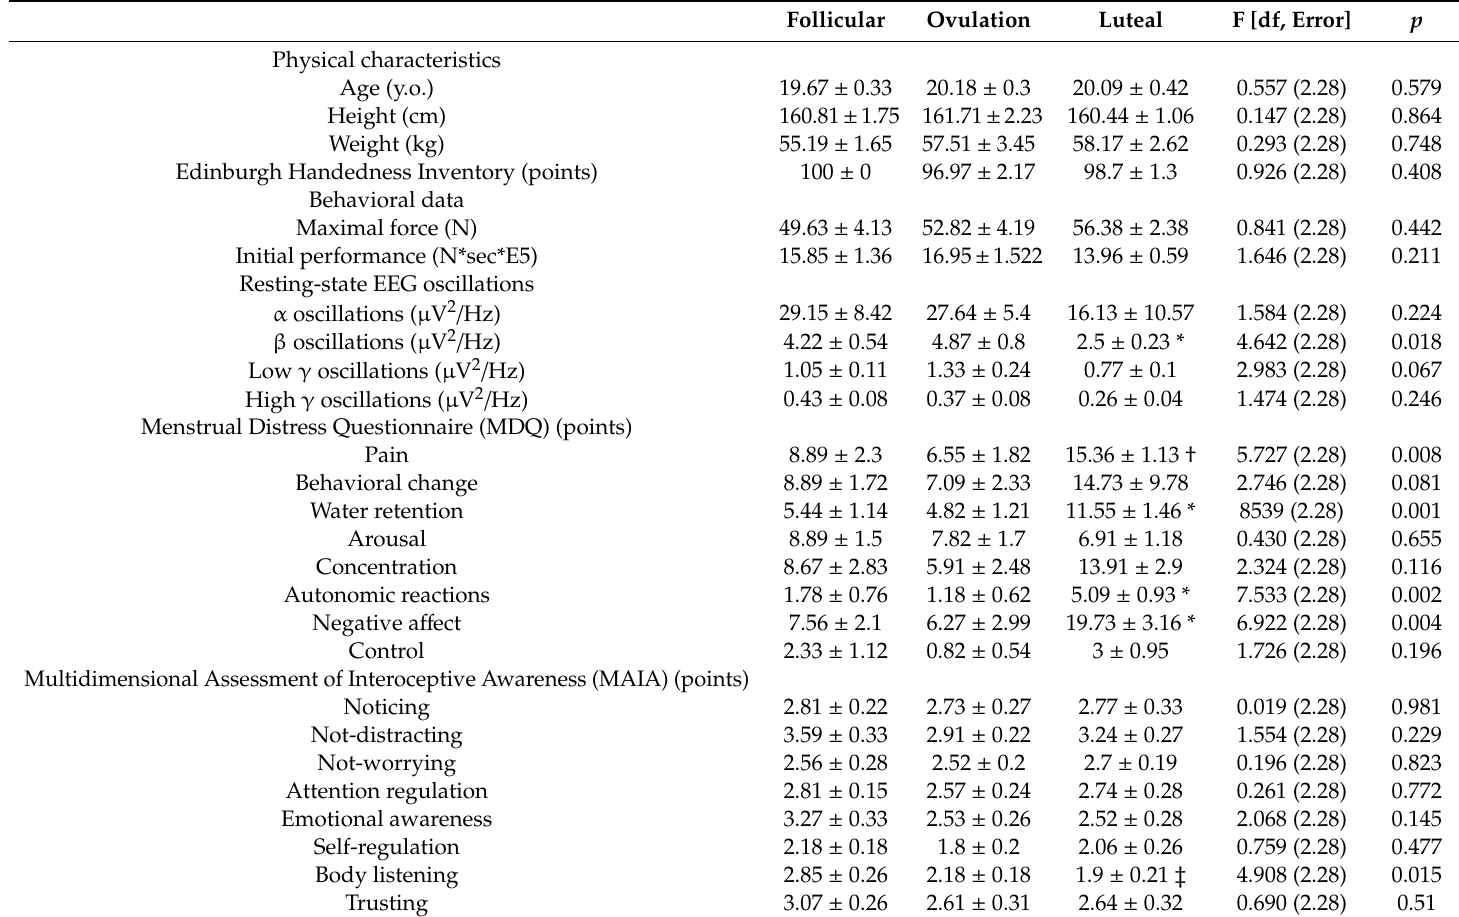
Table 1. Baseline assessments of the three